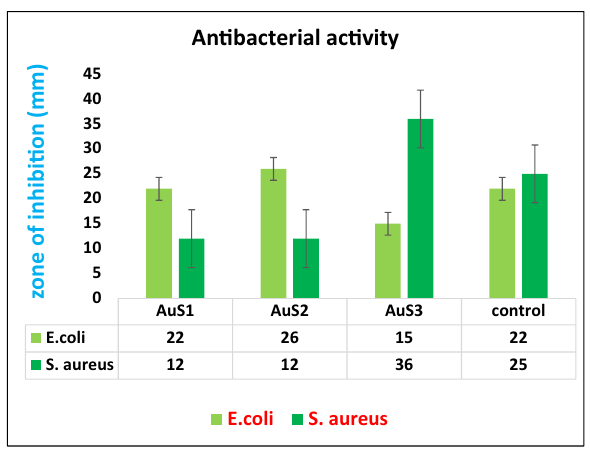
Fig. 12. Gold nanoparticles from site-I and site-III, i.e., AuS1 and AuS3 were highly active against F. oxysporum , they showed 46.41% of inhibition in both sites whereas, in site-II, i.e., AuS2 percentage of inhibition was 40.08%.